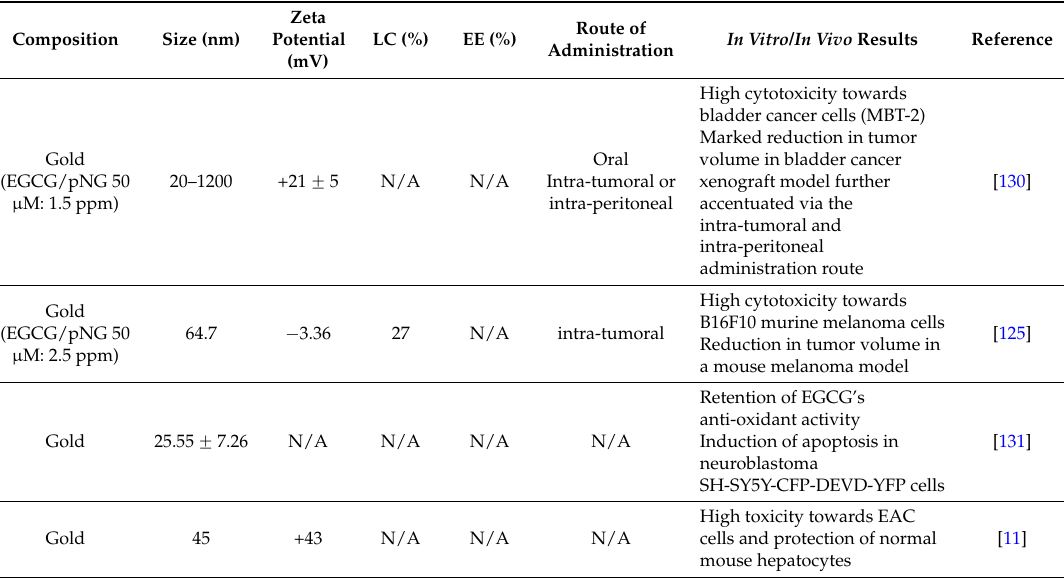
Table 1. Gold nanoparticles used as EGCG nanocarriers for cancer